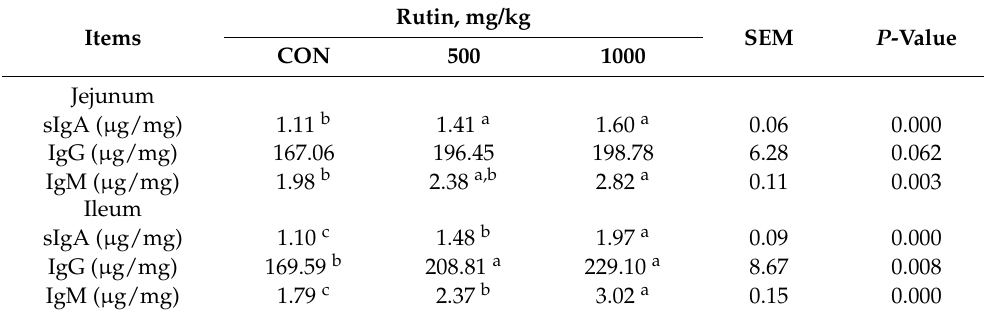
Table 6. Effect of rutin supplementation on the intestinal immunoglobulins levels of aged laying